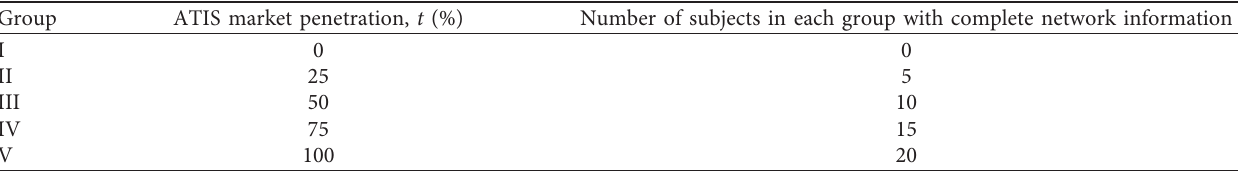
Table 2: Information conditions in the five groups of experiments.